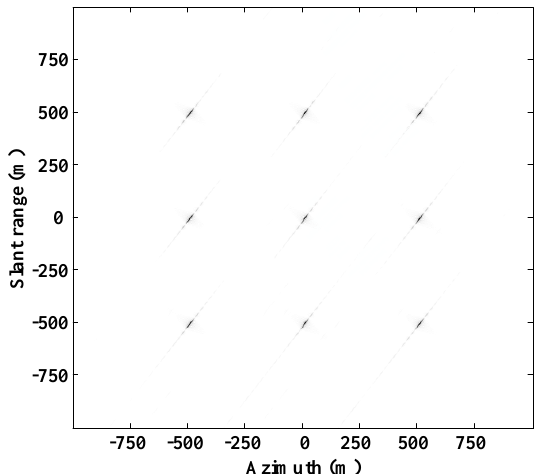
Figure 10. Focused SAR image of all 9 simulated point scatters.